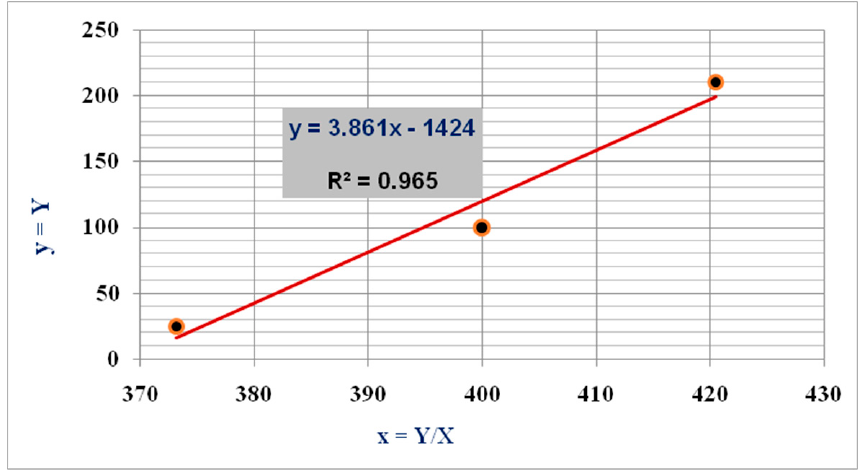
Figure 10. Graph of the linear function (x, y) for deducing the value of concrete cover thickness. According to the equation of the fitting line: y (cid:3404) 3.861 (cid:3400) x (cid:3398) 1424 , and the Equation